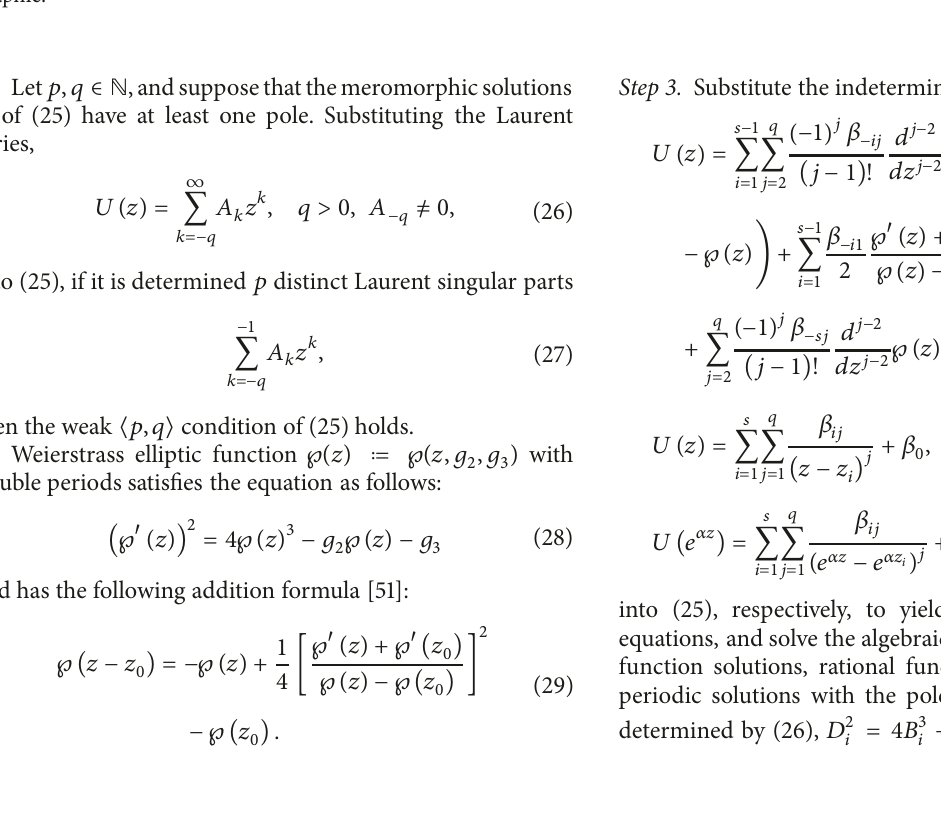
Figure 4: The 3D and 2D surfaces of 𝑢 4 (𝑧) by considering the values 𝛾 = 3 , 𝜇 = 2.5 , 𝑘 = 1 , 𝐿 = 1 , 𝜆 = −32 , 𝑦 = 0 , 𝑎 = 1 , and 𝑡 = 0 for the 2D